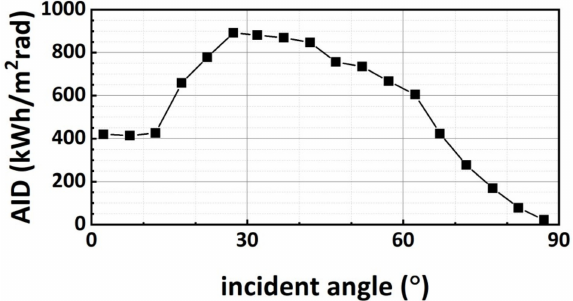
Figure 2. Annual irradiance density (AID) model on a horizontal plane, which was defined by the standard dataset, METPV11, from 47 capitals of the prefecture in Japan.